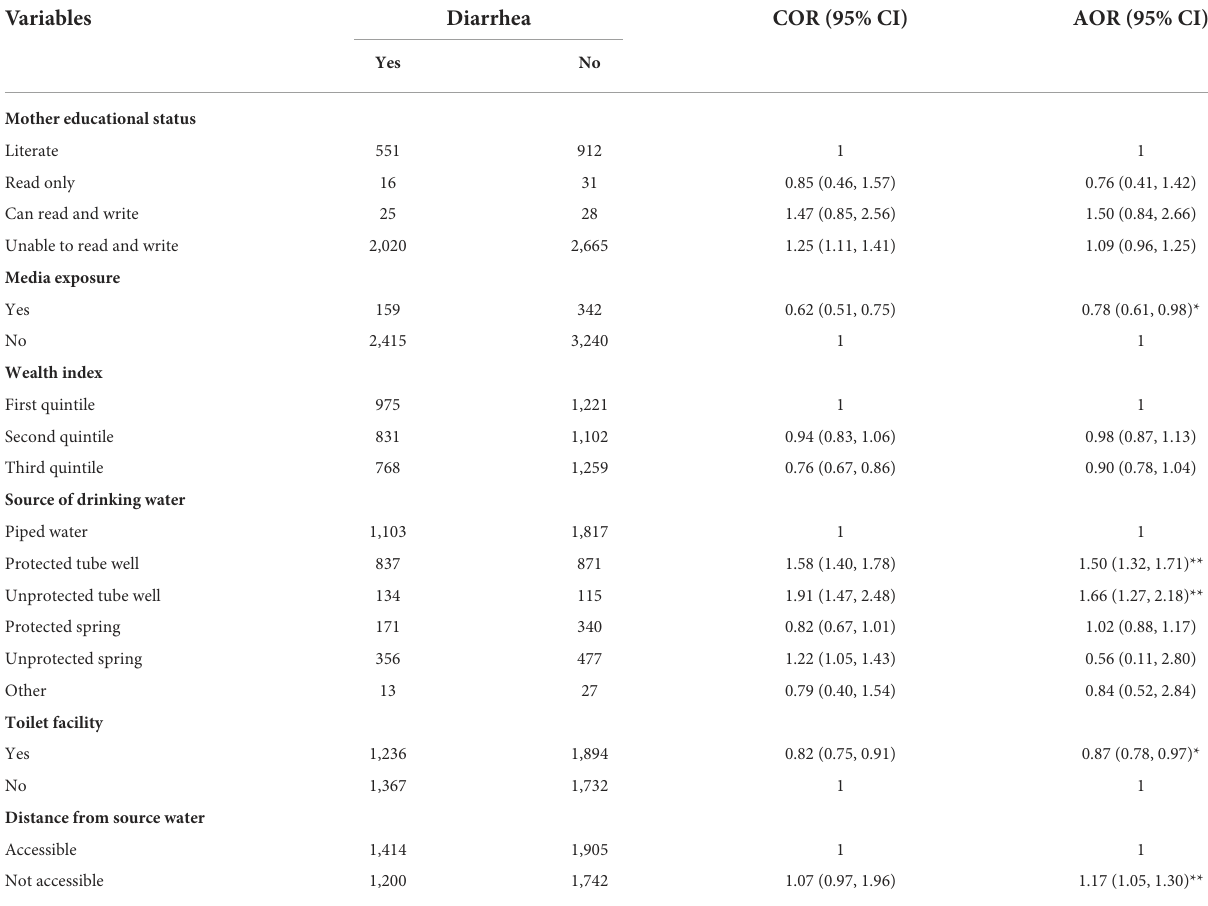
TABLE 3 Predictors associated with diarrhea among under five children in Kersa HDSS from 2015 to 2021.